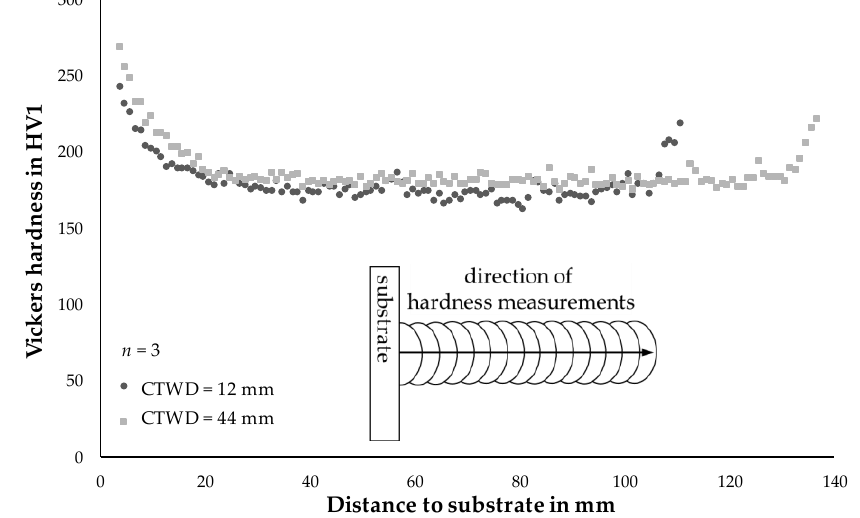
Figure 15. Hardness measurements of WAAM structures with differing CTWD for U = 20 V; v wire = 5 m/min and v weld = 0.4 m/min.